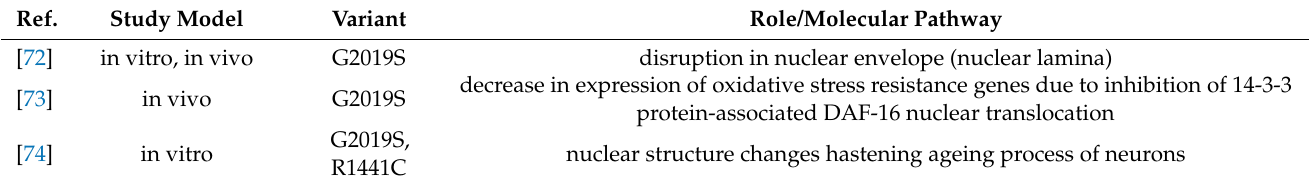
Table 9. Nucleus dysfunction and